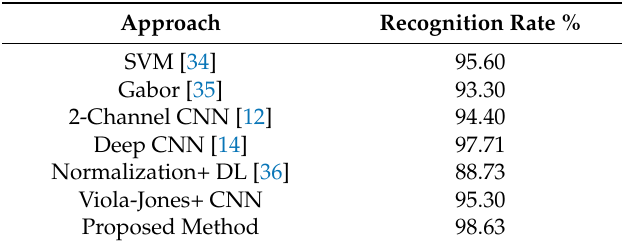
Table 8. The comparison between different approaches and our approach for the JAFFE face database. CNN— convolutional neural network.